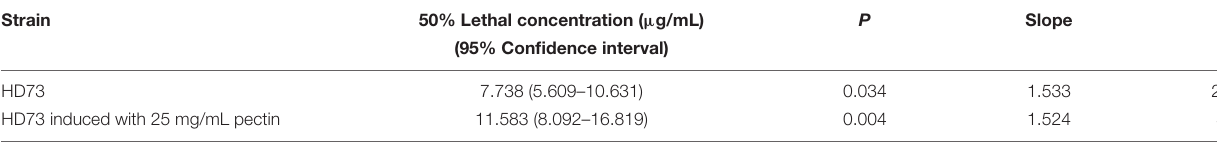
TABLE 3 | Dose–response insecticidal activity of the Cry1Ac of HD73 strains. Strain